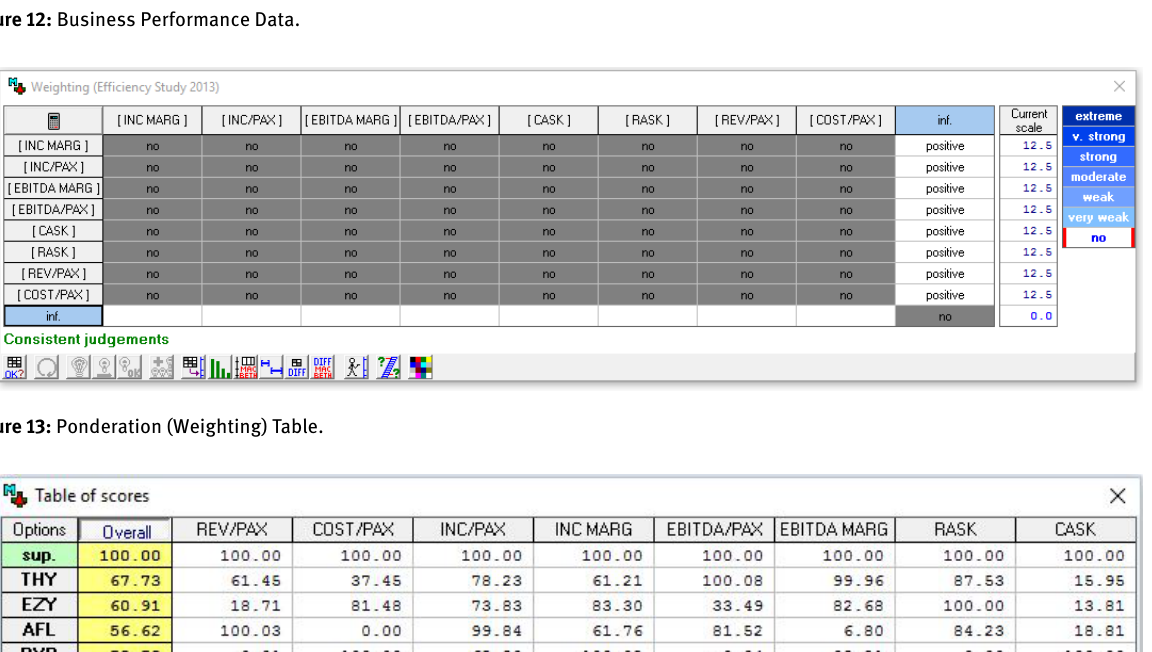
Figure 12: Business Performance Data.